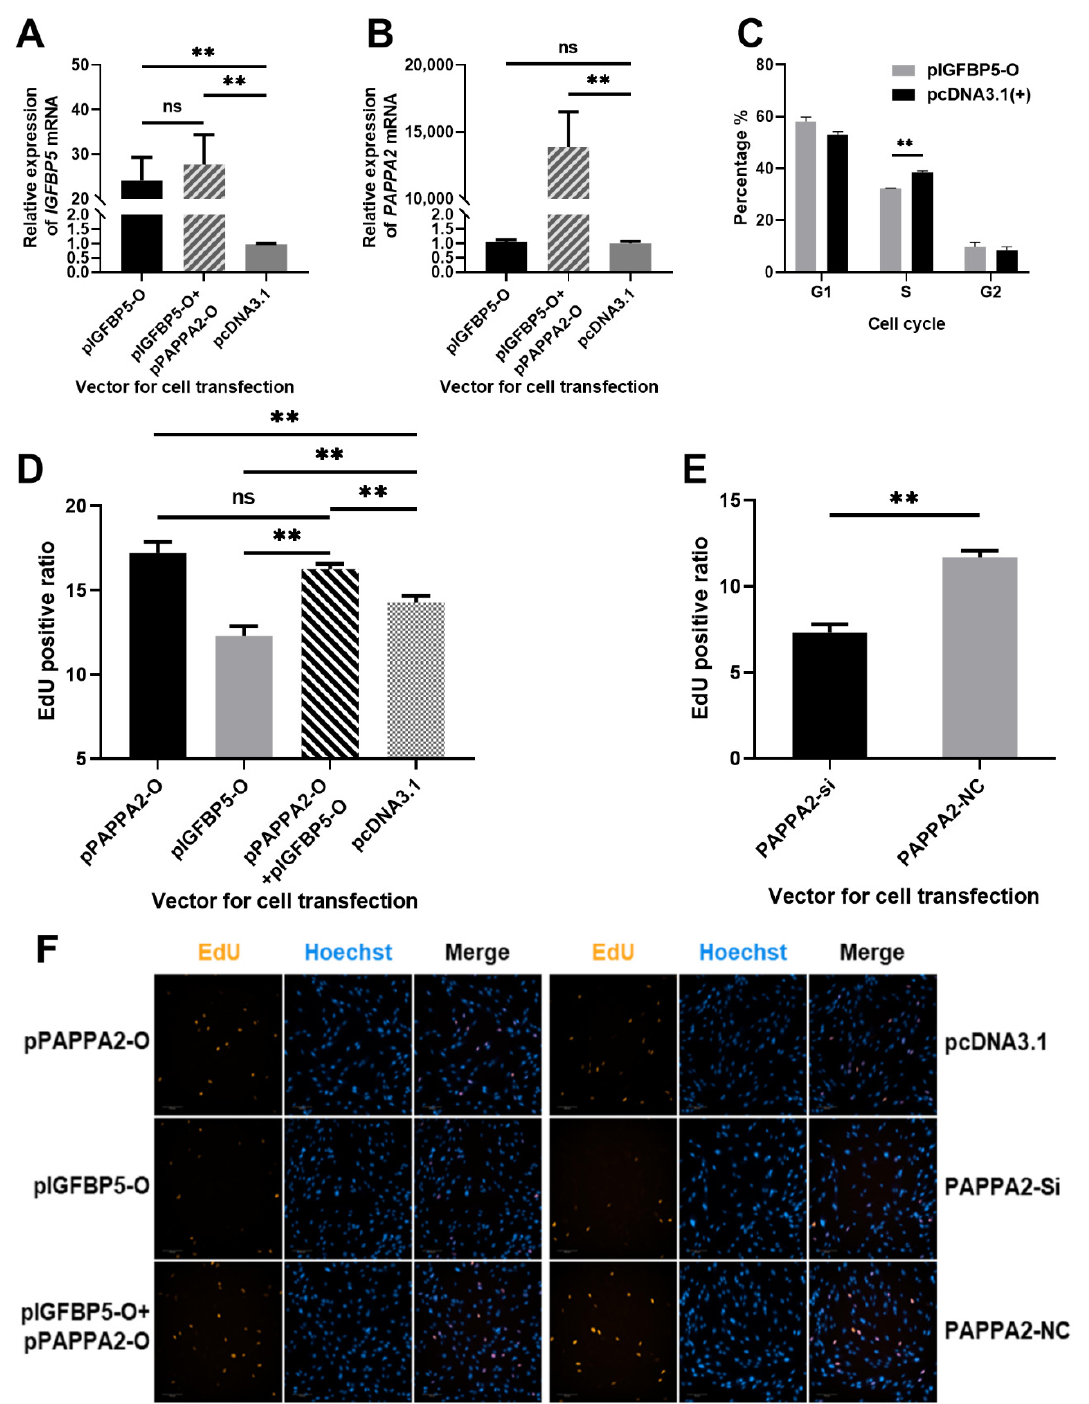
Figure 5. Effect of PAPPA2 and IGFBP5 on the proliferation of DPCs. Note: ( A ): Relative expression of IGFBP5 after transfection of pIGFBP5-O, pIGFBP5-O+pPAPPA2-O and pcDNA3.1 in DPCs. ( B ): Relative expression of PAPPA2 after transfection of pIGFBP5-O, pIGFBP5-O+pPAPPA2-O and pcDNA3.1 in DPCs, respectively. ( C ): Effect of IGFBP5 on the cycle of DPCs. ( D ): Proportion of EdU-positive cells after transfection with pIGFBP5-O, pPAPPA2-O, pIGFBP5-O+pPAPPA2-O and pcDNA3.1 in DPCs, respectively. ( E ): Proportion of EdU-positive cells after transfection with siRNA-2 and siRNA-NC of PAPPA2 in DPCs, respectively. ( F ): Fluorescence photos of EdU staining results in each group (200×). In this figure, “**” highly significant difference ( p < 0.01) and “ns” indicates non-significant difference.